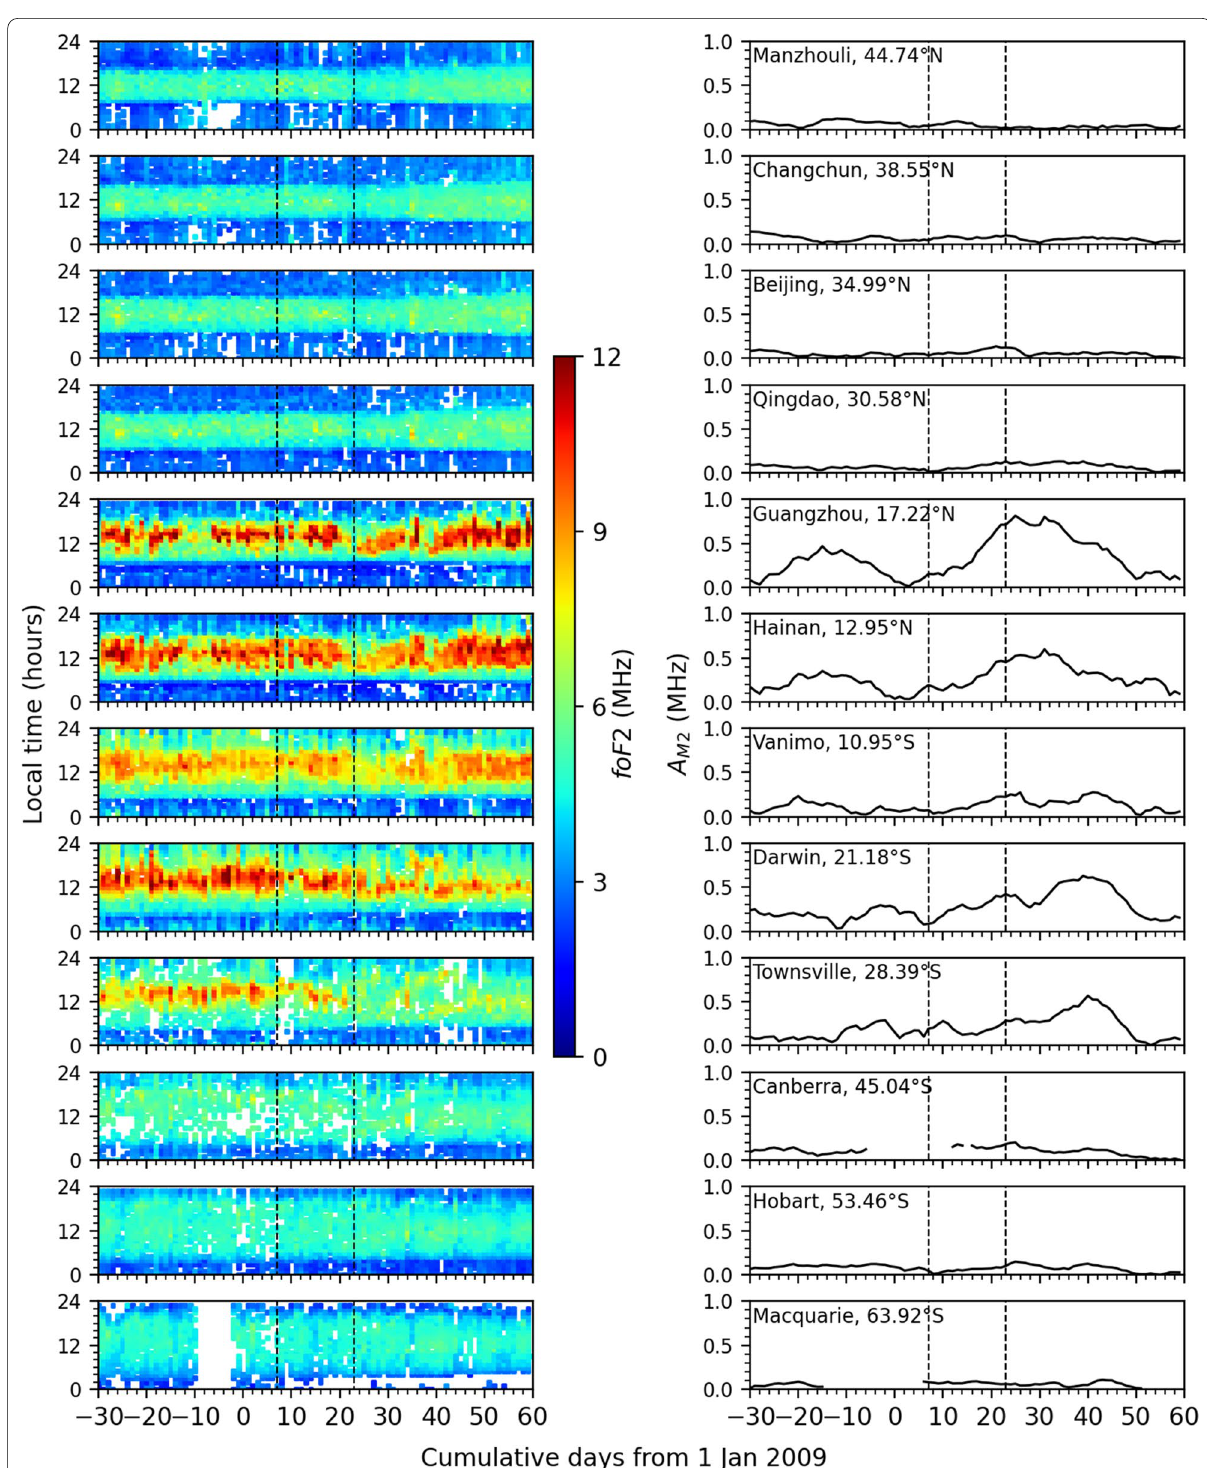
Fig. 5 The variations of foF2 data (left column) and the corresponding A M2 (right column) from a chain of ionosonde stations in the eastern Asia– Australia sector shown in Fig. 1. The corresponding geomagnetic latitudes of these stations are given in the right column. The vertical dashed lines are the same as those in Fig.